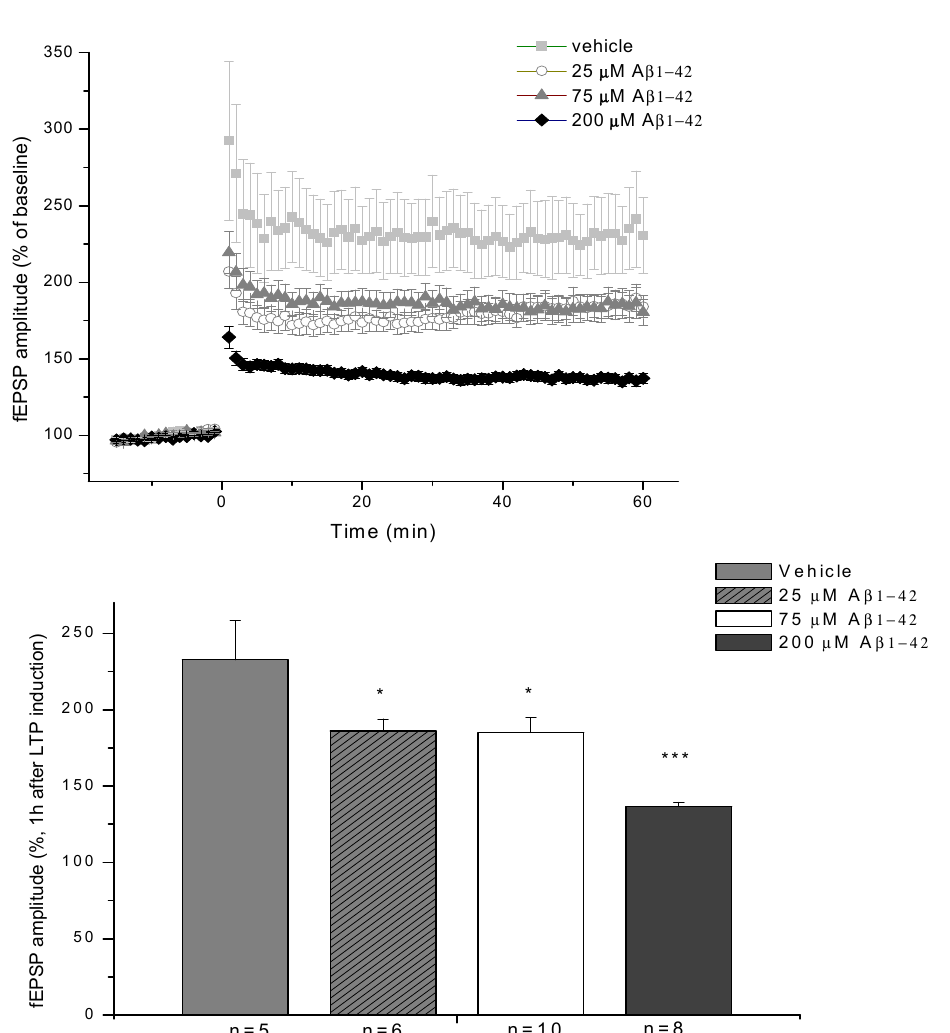
Figure 17. LTP impairment depends on the aggregation concentration. The effect of 24 h/75 µ M, 24 h/25 µ M and 24 h/200 µ M oA β samples on LTP in HC slices. The histogram shows the level of fEPSP potentiation between 55 and 60 min post-TBS. Error bars represent mean ± SEM. * p ≤ 0.05 and *** p ≤ 0.001.